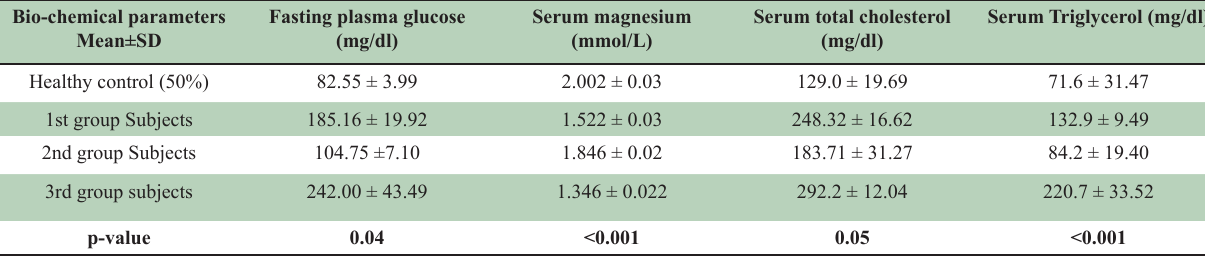
Table-II: Biochemical parameter